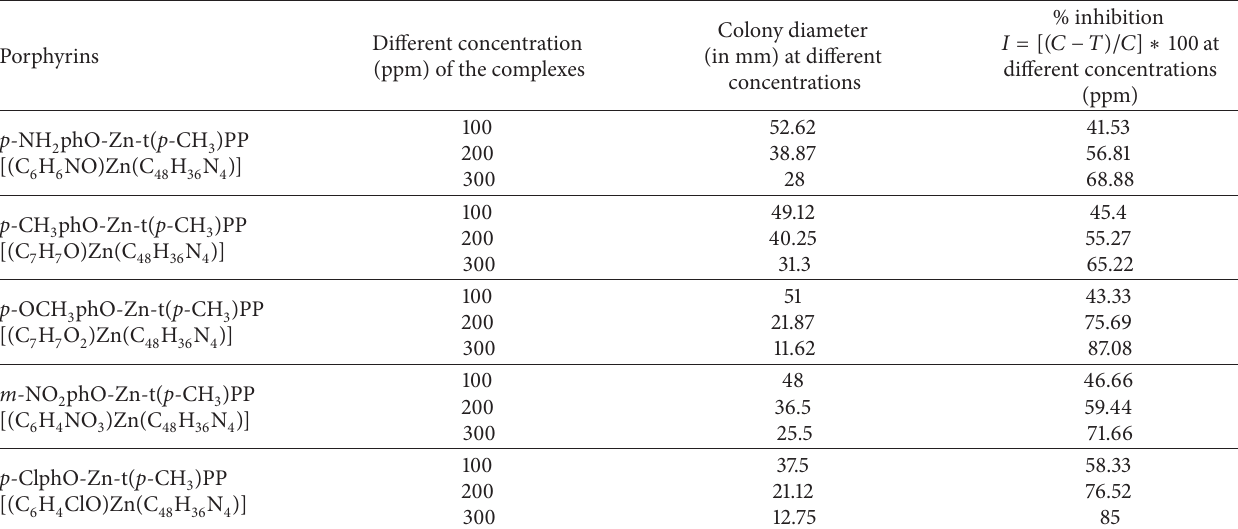
Table 7: In vitro efficacy of axially ligated X-Zn-t( p -CH Colony diameter of control 𝐶 = 90 mm.